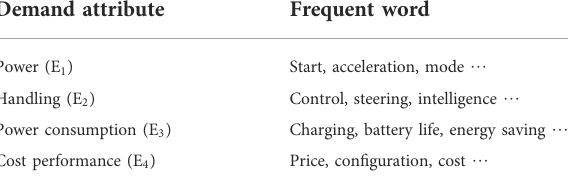
TABLE 8 Main sentiment words included in WR + and WR − . WR + WR −